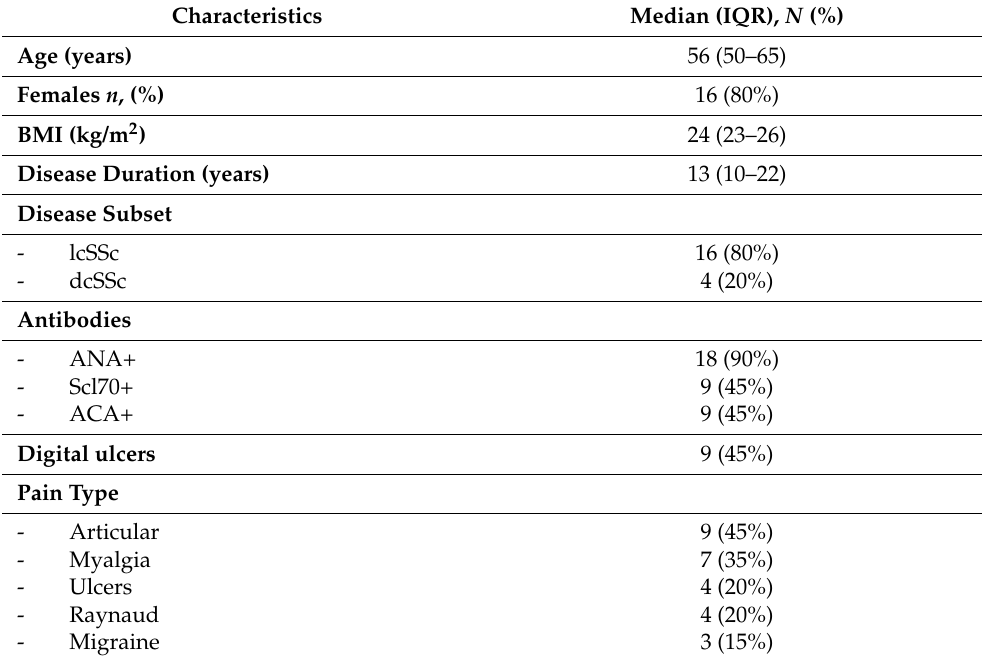
Table 1. Demographic and clinical features of SSc